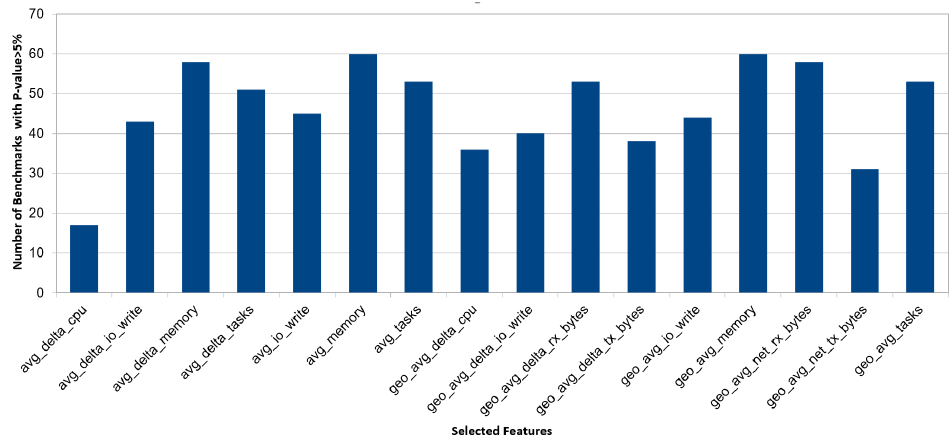
Figure 6. Number of benchmarks that surpass the 5% threshold of p -value for every selected